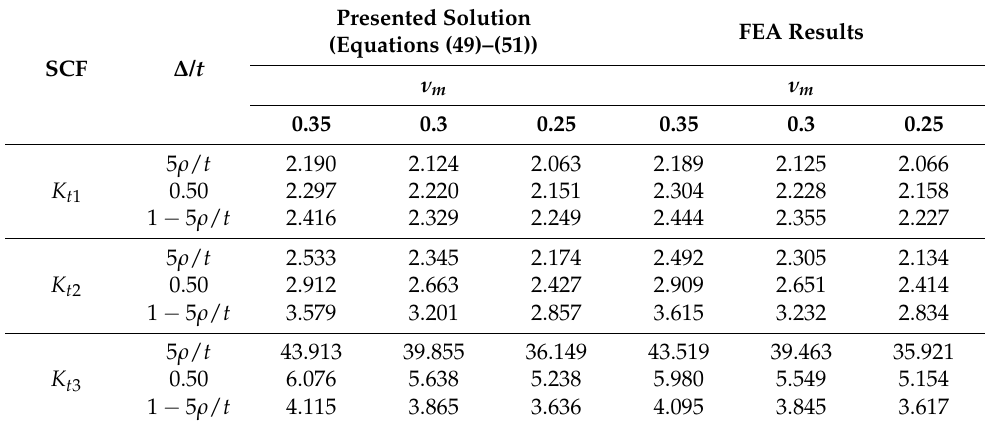
Table 2. Comparison of analytical and FEA results of SCFs near the porosity of radius of 0.5 mm and κ = 3.1.